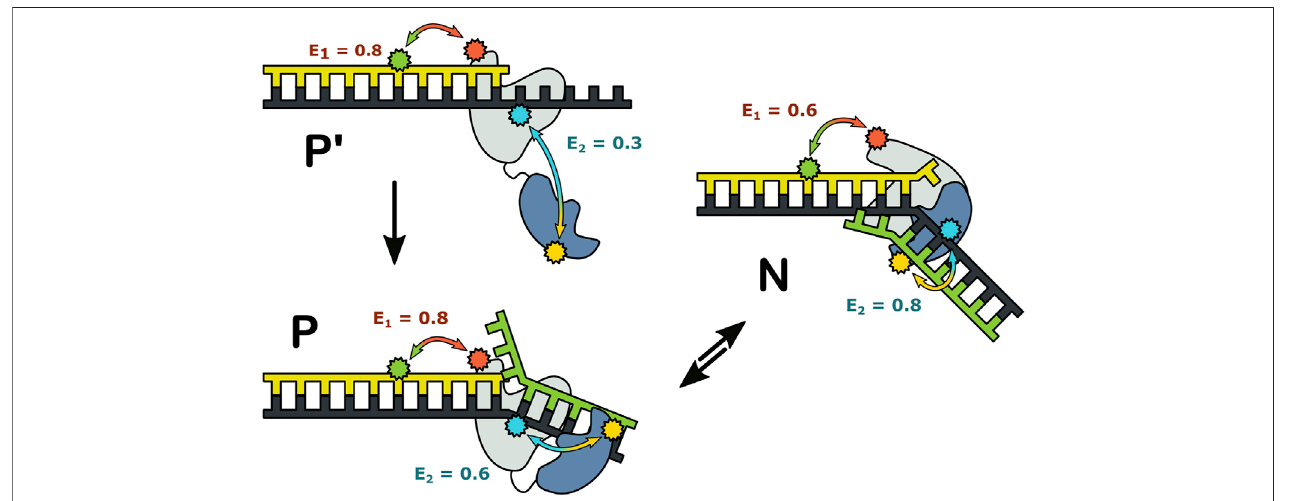
FIGURE 12 | Possible con fi gurations of Pol I — DNA complexes. The FRET ef fi ciencies measured with labeling are denoted E 1 and E 2 , respectively. Reproduced from reference (Pauszek et al., 2021) with permission.